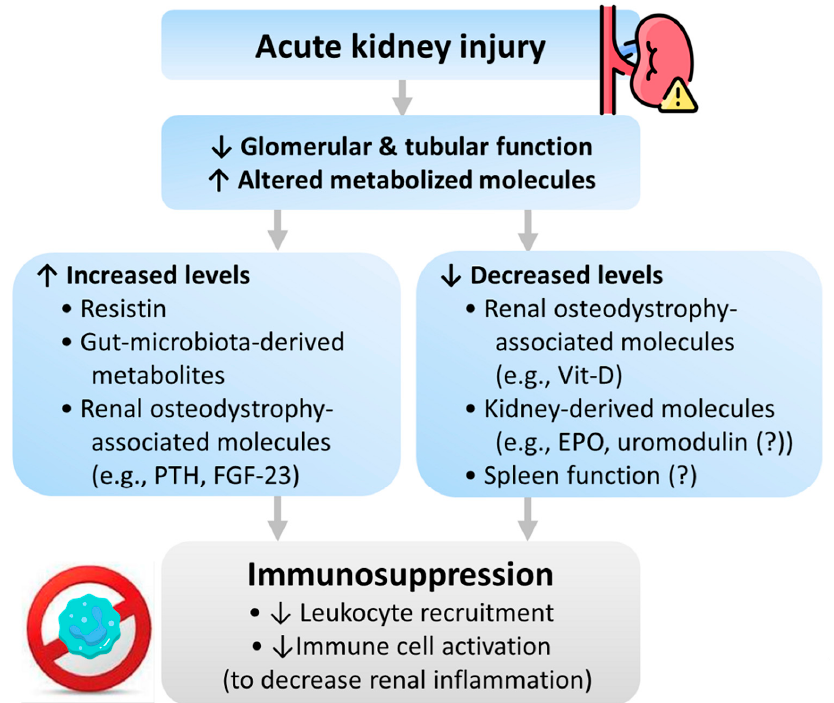
Figure 3. Pathophysiology of immunosuppression following AKI. Abbreviations: EPO, erythro- poietin; FGF-23, fibroblast growth factor-23; PTH, parathyroid hormone; Vit-D, vitamin D.